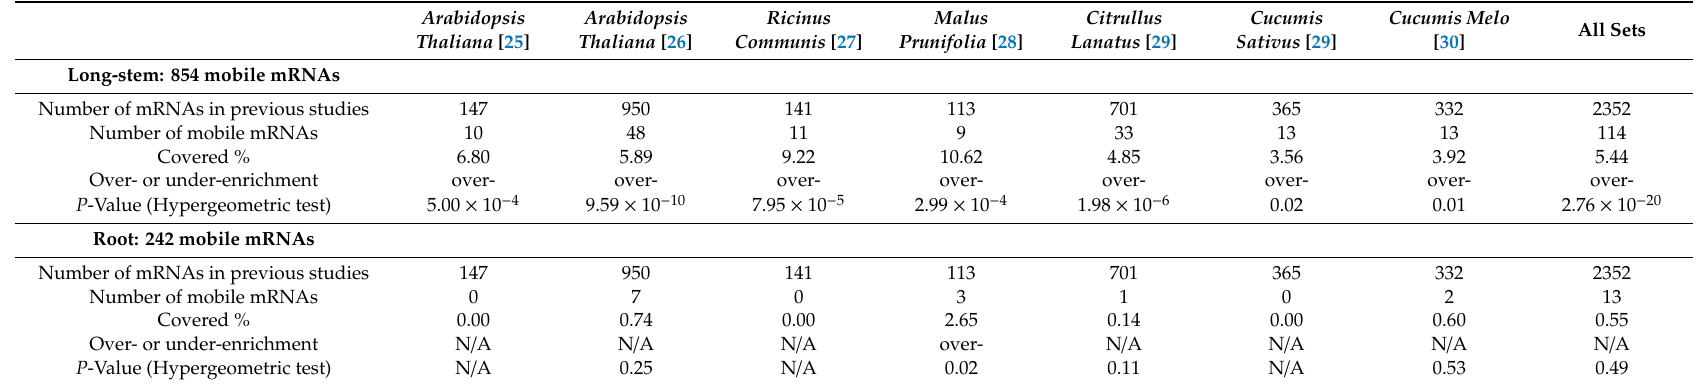
Table 2. Comparison of the “stem portion” mobile mRNAs and the “root portion” mRNAs identified from the N. benthamiana / tomato heterografts grown under normal condition with phloem mRNAs identified from previous